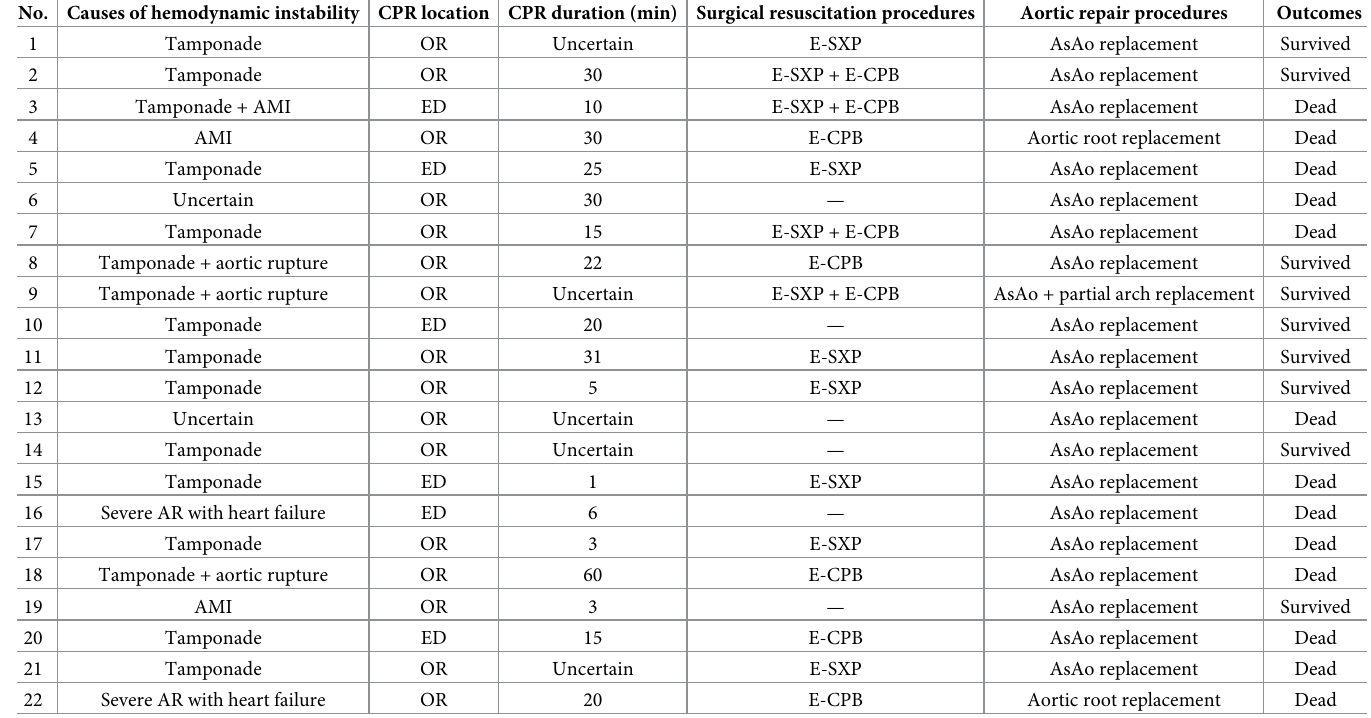
Table 1. Characteristics of CPR, type of aortic repair procedures, and